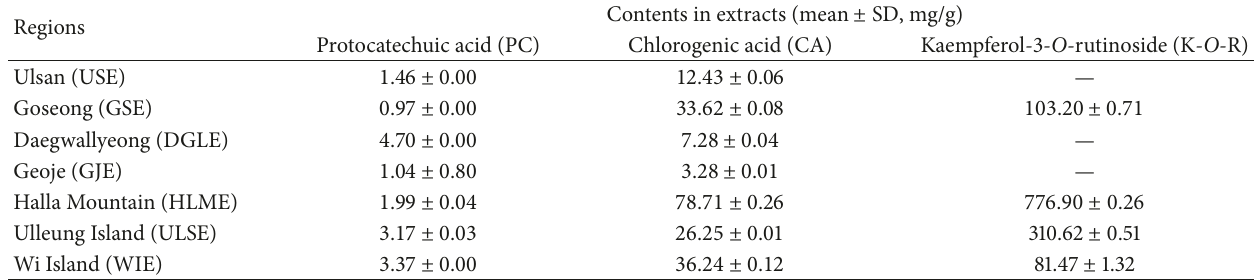
Table 5: Quantification of protocatechuic acid, chlorogenic acid, and kaempferol-3- O -rutinoside from Solidago virgaurea subsp. gigantea samples from different